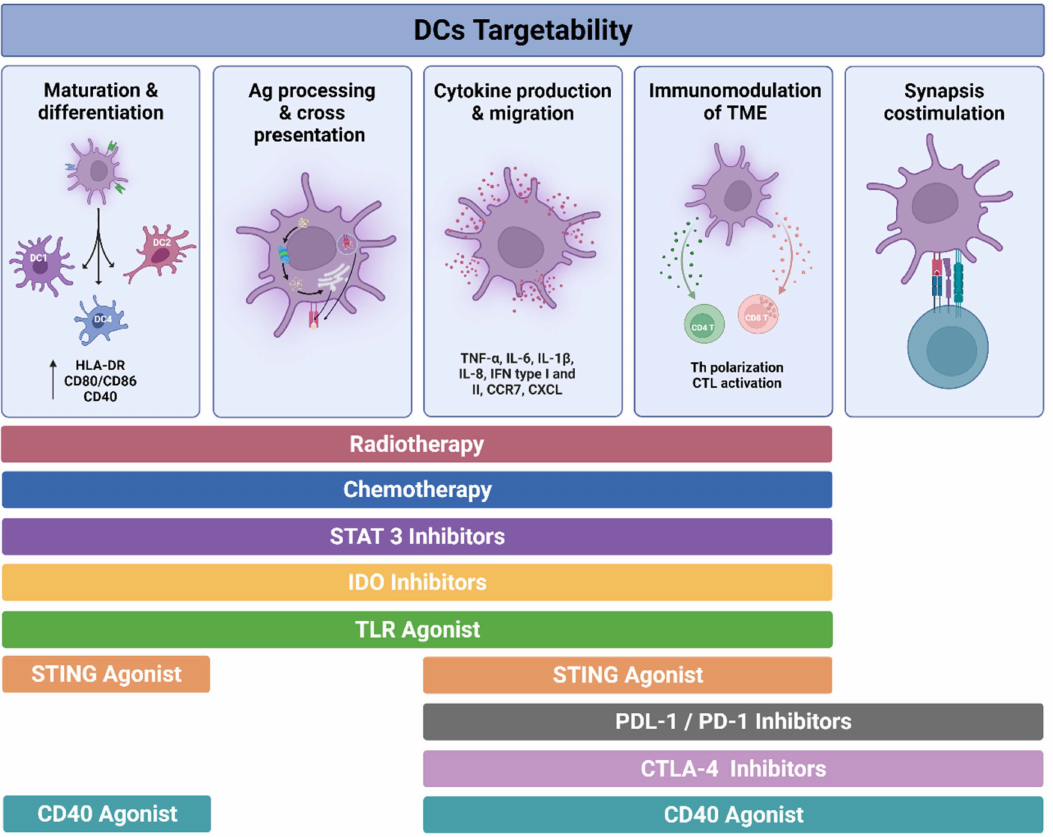
Figure 3. Strategies to target DCs in cancer. Five mechanisms are shown that can be targeted by various therapeutic approaches that are shown in the rows below. This may not be inclusive of all targetable mechanisms or potential therapeutic